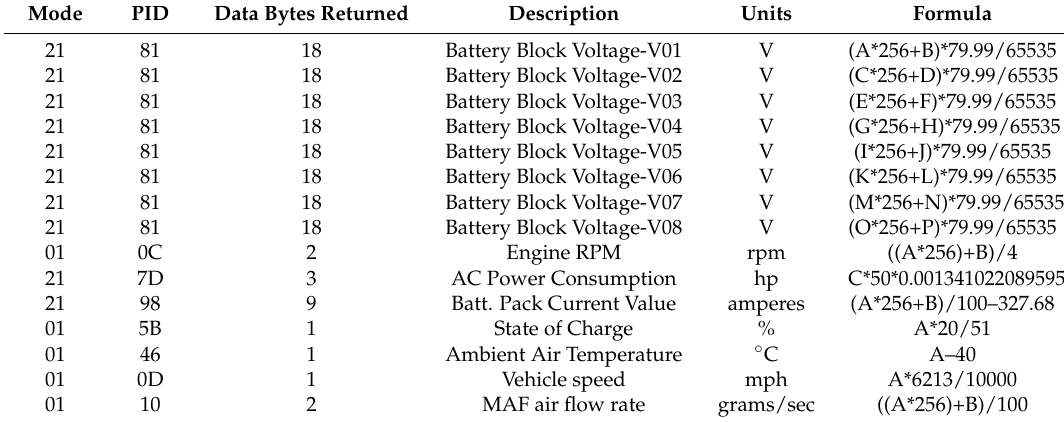
Table 1. List of on-board diagnostic parameter identifications (PID) used in testing. Mode 21 signifies a Toyota defined PID. Letters represent the location of the value in the OBD-II output